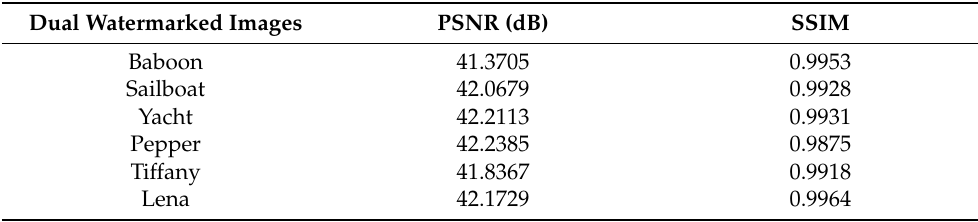
Table 1. PSNR and SSIM values of different dual watermarked images.